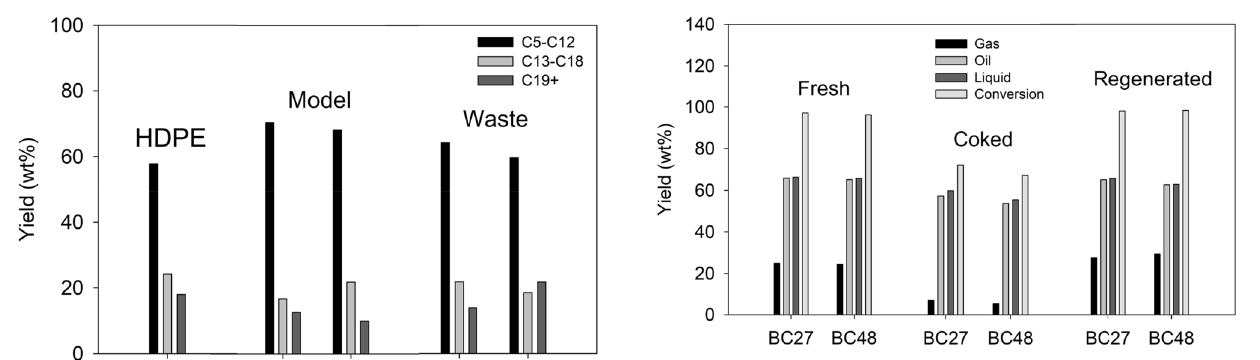
Fig. 12 Results of GC analysis of the n -heptane soluble liquids obtained by the catalytic hydroconversion of indicated plastic materi- als over BC27 and BC48. 500 ml autoclave reactor, 20 bar initial cold hydrogen pressure, 60 min residence time, and 20:1 feed-to-catalyst ratio (by weight)